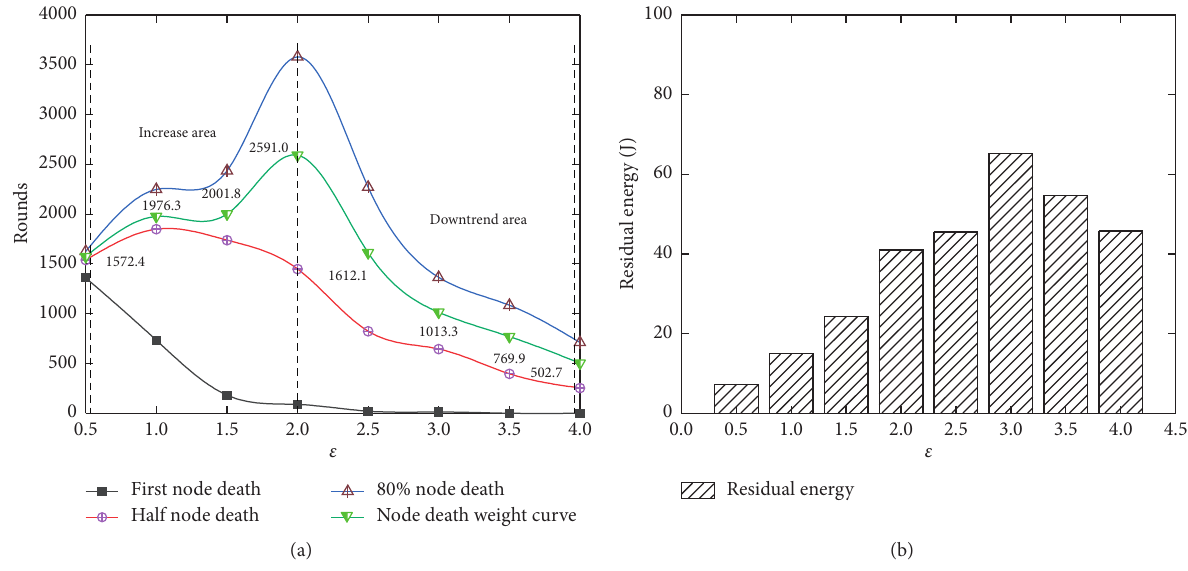
Figure 5: Assessment metrics with varying ε : (a) death round with varying ε and (b) residual energy with varying ε